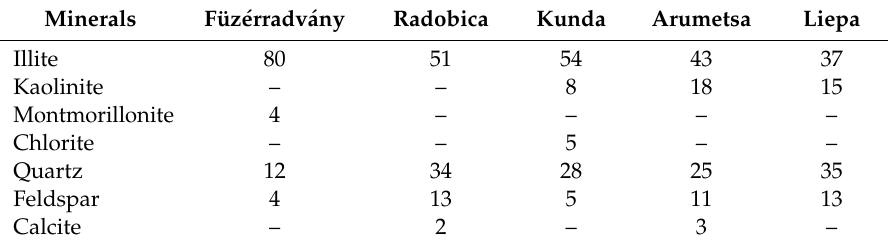
Table 1. Mineral composition of the investigated clays (in mass%)